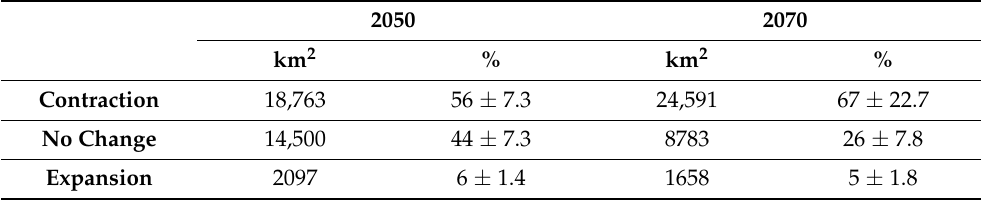
Figure 2. Environmental suitability for E. delegatensis in Tasmania as determined by an ensemble mean of 3 SDMs (Maxent, MARS and ANN) under historical (1960–1990) and projected future climates for mid (2041–2060) and end of century (2060–2081) according to global climate models ACCESS1.0, CNRM-CM5 and MIROC5, with ensemble mean of the 3 GCMs for each time period. Table 3. Change in species range for E. delegatensis according to the mean of 3 SDMs (Maxent, MARS and ANN) and 3 global climate models (GCMs) (ACCESS1.0, CNRM-CM5 and MIROC5) as a percentage of initial distribution and areal extent (km 2